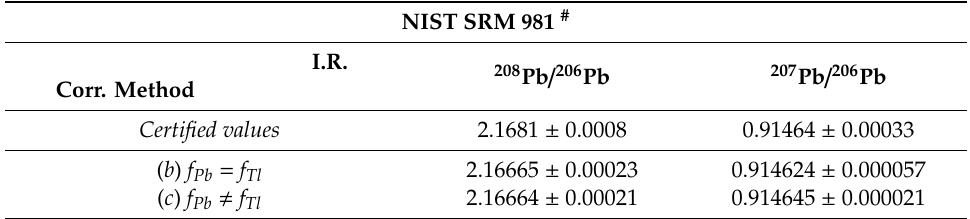
Table 2. Lead I.R. values obtained with di ff erent correction methods for the NIST SRM 981 standard solutions and respective uncertainties, u = 2s.